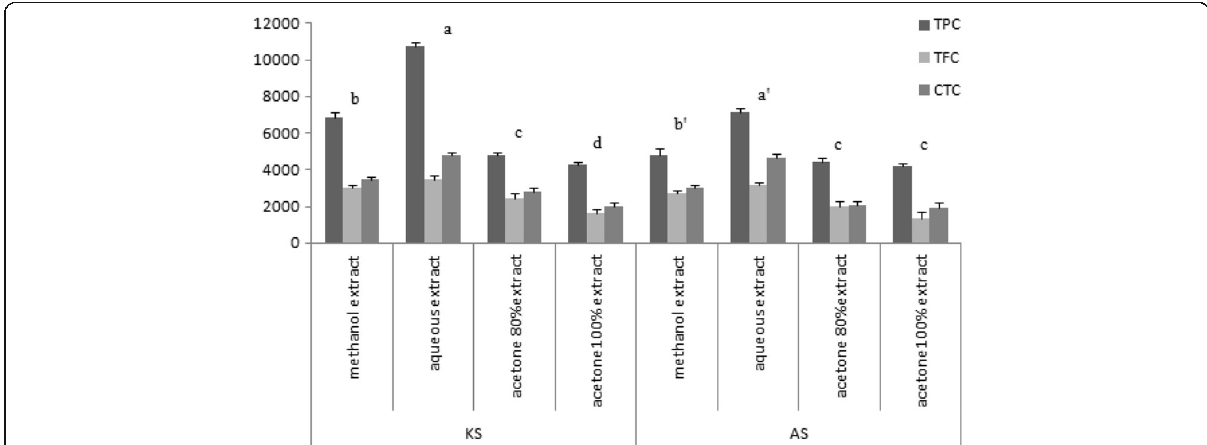
Fig. 1 Effect of different solvents on phytochemical composition of both date seeds. Data expressed as means ± standard deviations of three independent extractions ( n = 3). TPC: Total phenolic content (mg GAE per 100 g of extract), TFC: Total flavonoid content (mg CE per 100 g of extract), CTC: Condensed tannins contents (mg CE per 100 g of extract), Different lower case letters in the same types of material indicate significant differences between the different used solvents extraction ( P < 0.05). KS: Korkobbi seed, AS Arechti